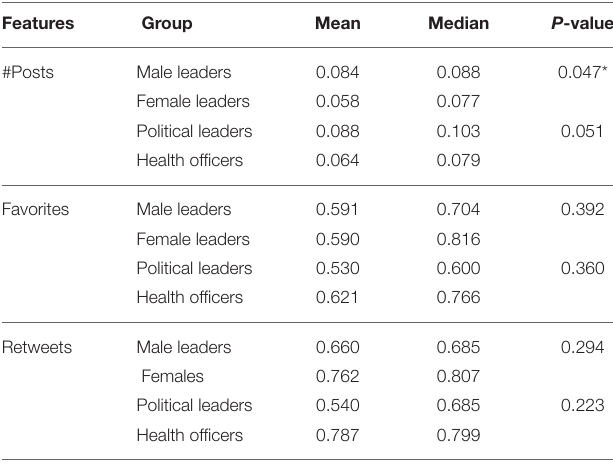
TABLE 3 | Offense in replies of posts authored by health